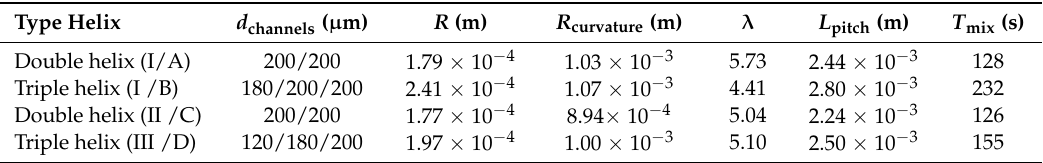
Figure 10. ( A ) Reynolds and Péclet numbers inside double and triple helices; ( B) the Dean number and ( C) the pressure drop/unit length along double and triple helices. ( C ) the pressure drop/unit length along double and triple helices. Table 2. Characteristics of the helices used. Table 2. Characteristics of the helices